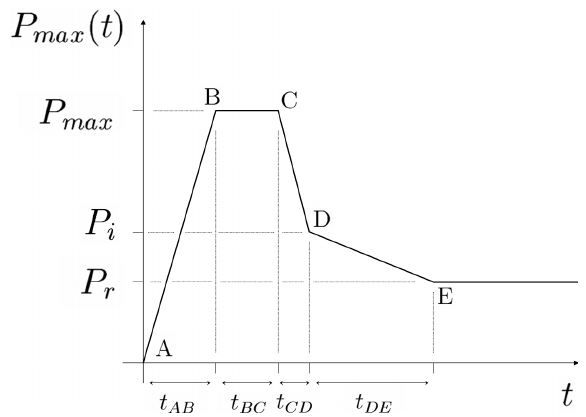
Fig. 5. Time evolution of the maximum pressure ( P max (t) ) of the pressure field ( P (x, z, t